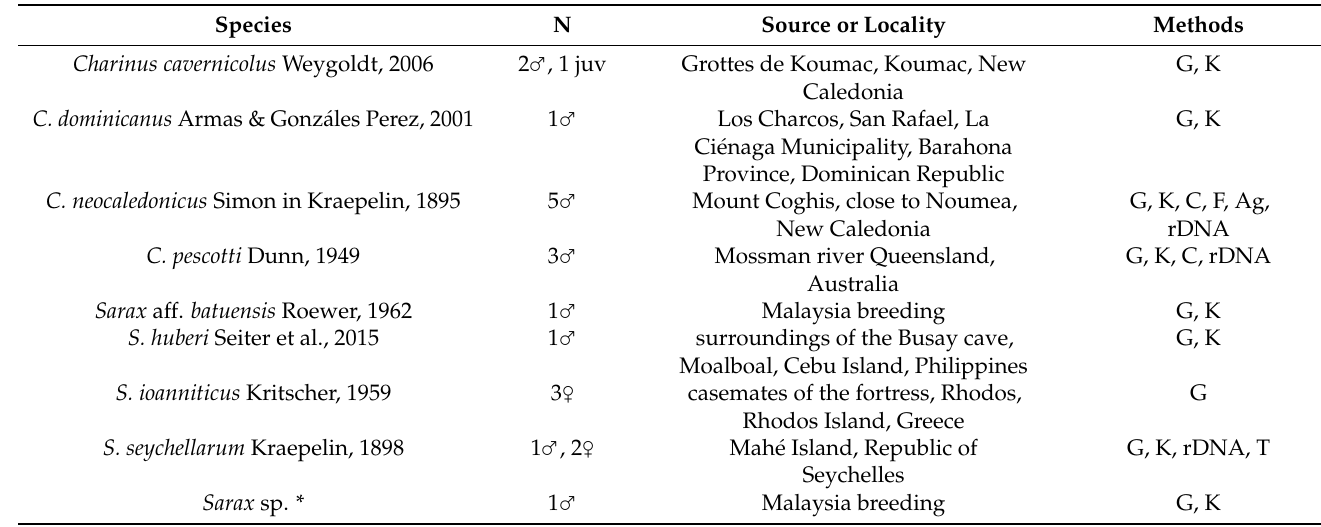
Table 1. Studied species, number of analyzed individuals and their sex, collection sites, and methods applied. Species N Source or Locality